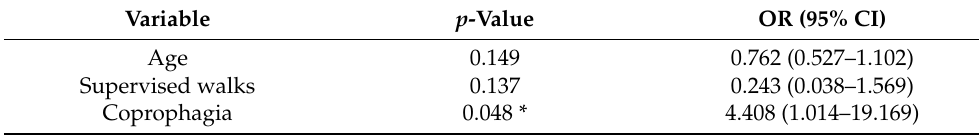
Table 4. Multivariable analysis of ESBL-PE gut colonization by healthy dogs in